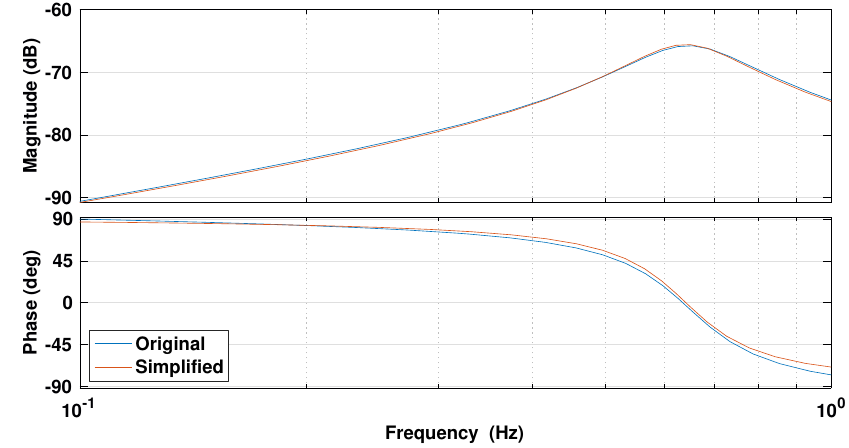
Figure 2. Bode diagram of the original (fourth order) and simplified (second order)